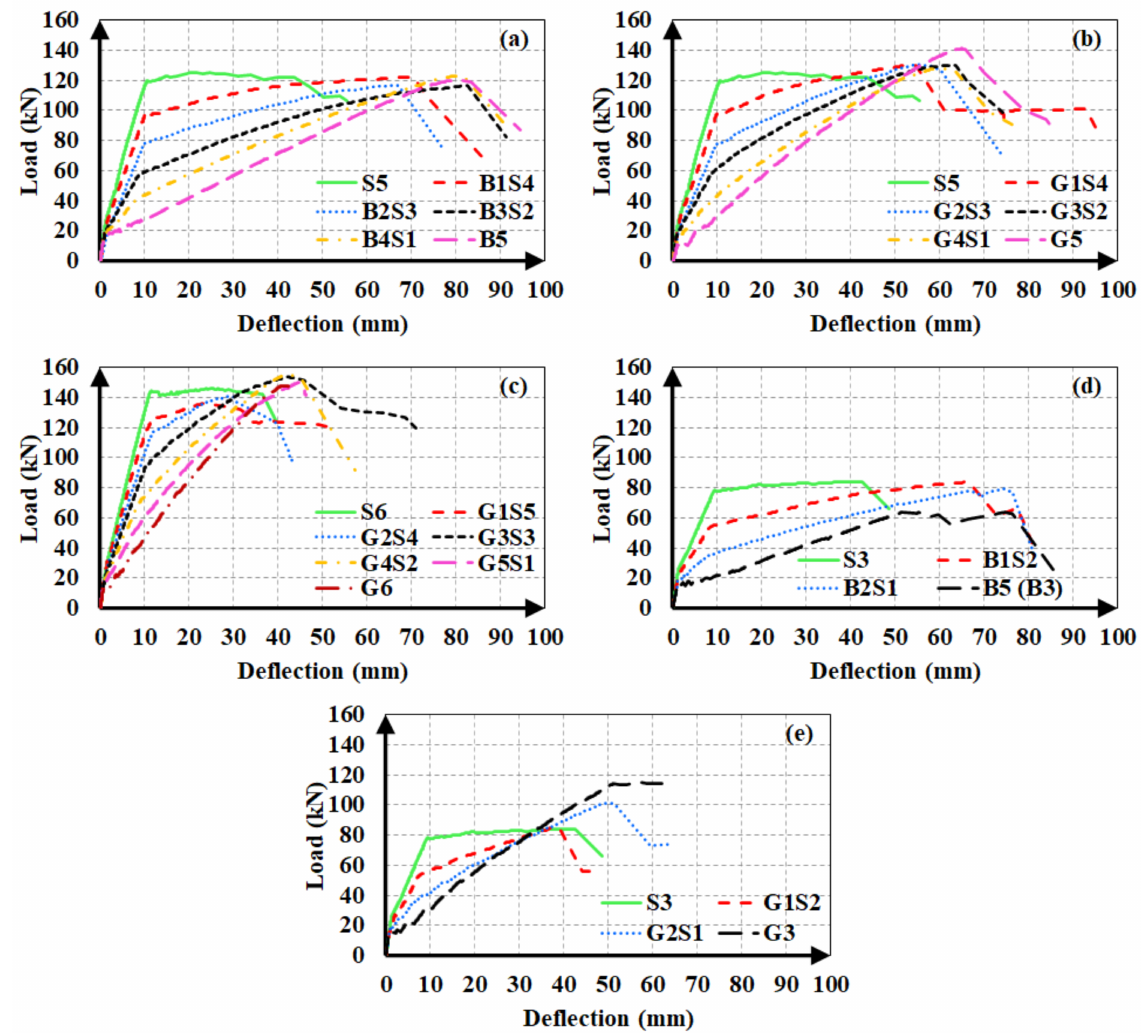
Figure 4. Load-deflection curves of the ( a ) first group with BFRP; ( b ) first group with GFRP; ( c ) second group; ( d ) third group with BFRP; and ( e ) third group with